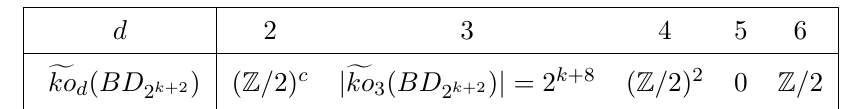
from degree 2 through 6 2 k +2